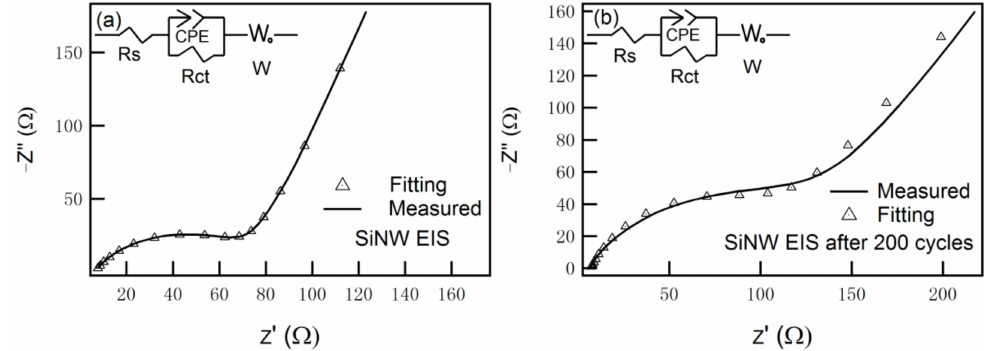
Figure 8. Typical electrochemical impedance spectra of 1D–PSiNW anodes measured at open-circuit voltage E ≈ 2.0 V (Li/Li + ): ( a ) fresh cell; ( b ) after 200 cycles at a current density of 8.0 A · g − 1 (inset is the equivalent circuit used to fit the electrochemical impedance (EIS)).